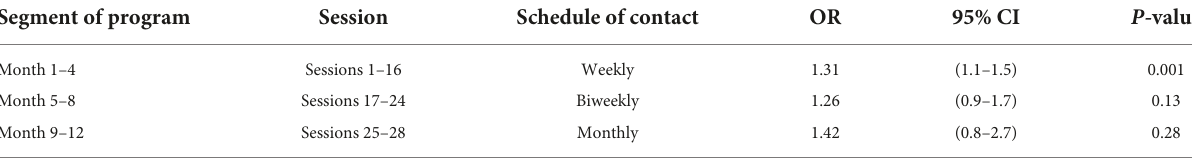
TABLE 2 Association between logon hours for CHF-CePPORT program segments and 12-month KCCQ-OS tertile. Segment of program